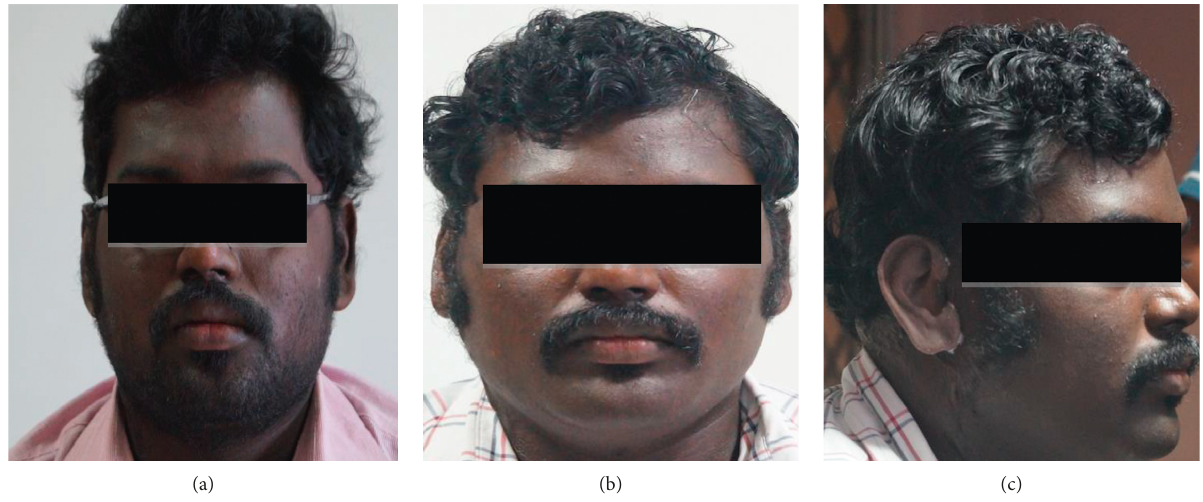
Figure 7: Frontal and profile photographs after insertion of ear